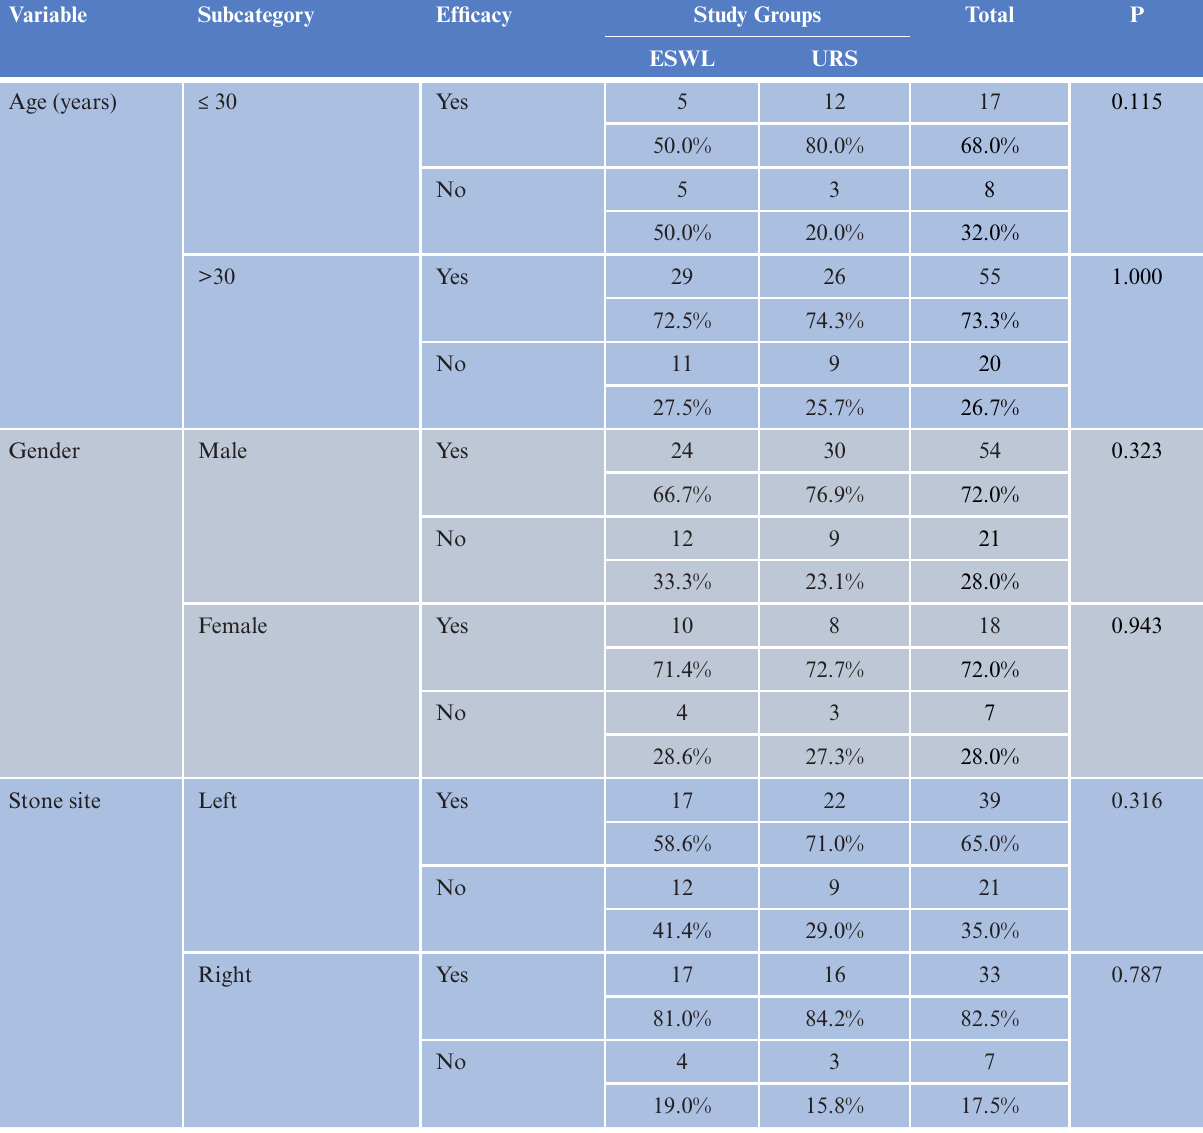
Table 4: Comparison of outcome between study groups stratified by age, gender, and site of